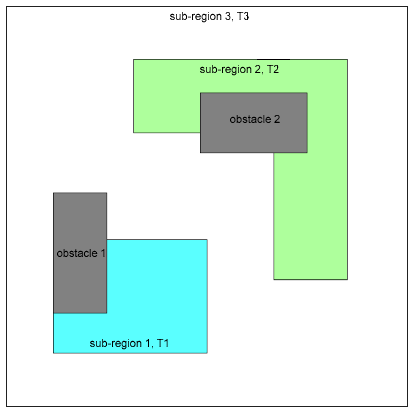
Figure 2. Sub-regions and obstacles in the task area. The cyan area is sub-region 1. The green area is Figure 2. Sub ‐ regions and obstacles in the task area. The cyan area is sub ‐ region 1. The green area is sub-region 2. The white area is sub-region 3. Gray areas refer to sub ‐ region 2. The white area is sub ‐ region 3. Gray areas refer to obstacles.